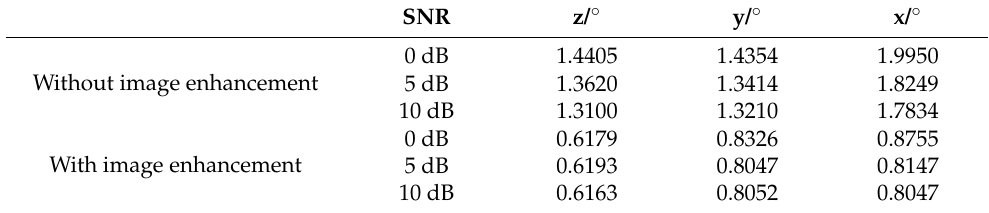
Table 7. Average Euler angle estimation error values of test set under different SNR